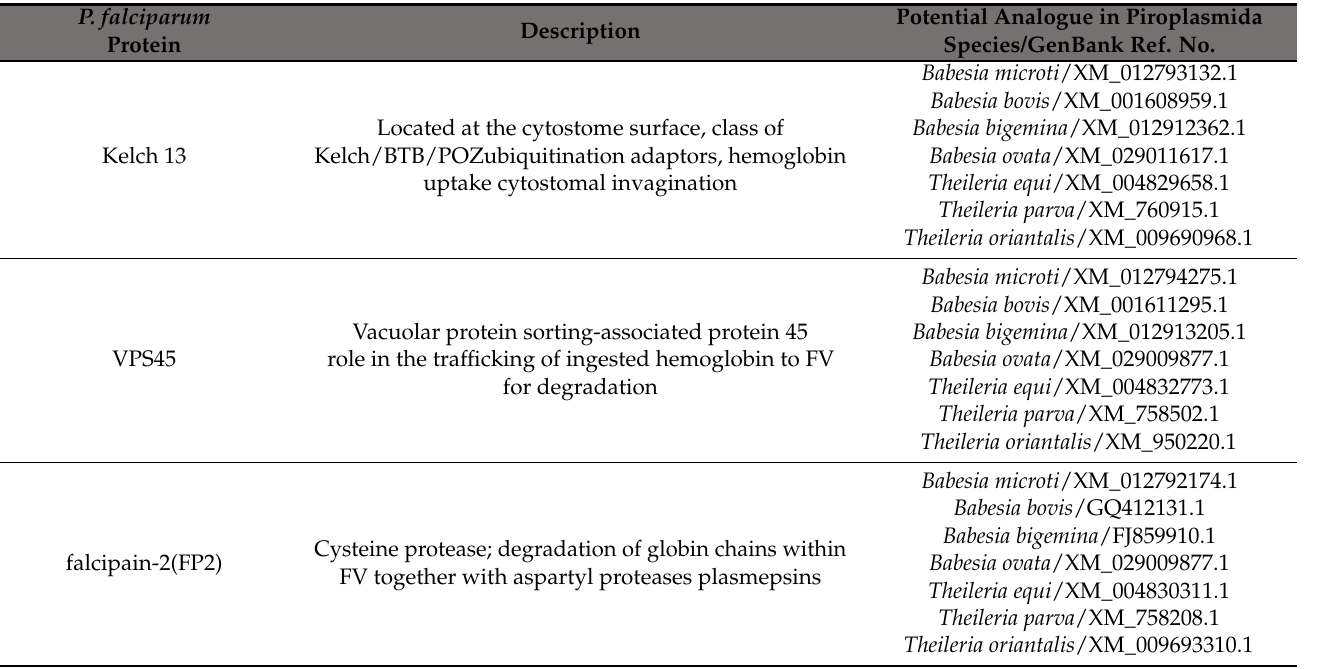
Table 1. Three molecules involved in the uptake and processing of hemoglobin in intraerythrocytic P. falciparum and their potential analogues in selected Babesia / Theileria